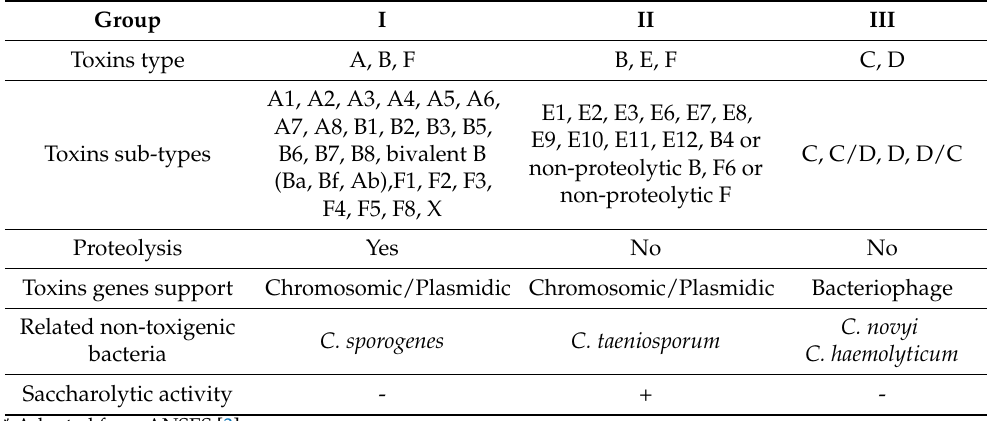
Table 1. Classification and characteristics of principal Clostridium botulinum strains and their toxins *. Group I II III Toxins type A, B, F B, E, F C, D A1, A2, A3, A4, A5, A6, E1, E2, E3, E6, E7, E8, A7, A8, B1, B2, B3, B5, E9, E10, E11, E12, B4 or C, C/D, D, D/C B6, B7, B8, bivalent B Toxins sub-types non-proteolytic B, F6 or (Ba, Bf, Ab),F1, F2, F3, non-proteolytic F F4, F5, F8, X Proteolysis Yes No No Toxins genes support Chromosomic/Plasmidic Chromosomic/Plasmidic Bacteriophage Related non-toxigenic bacteria - +